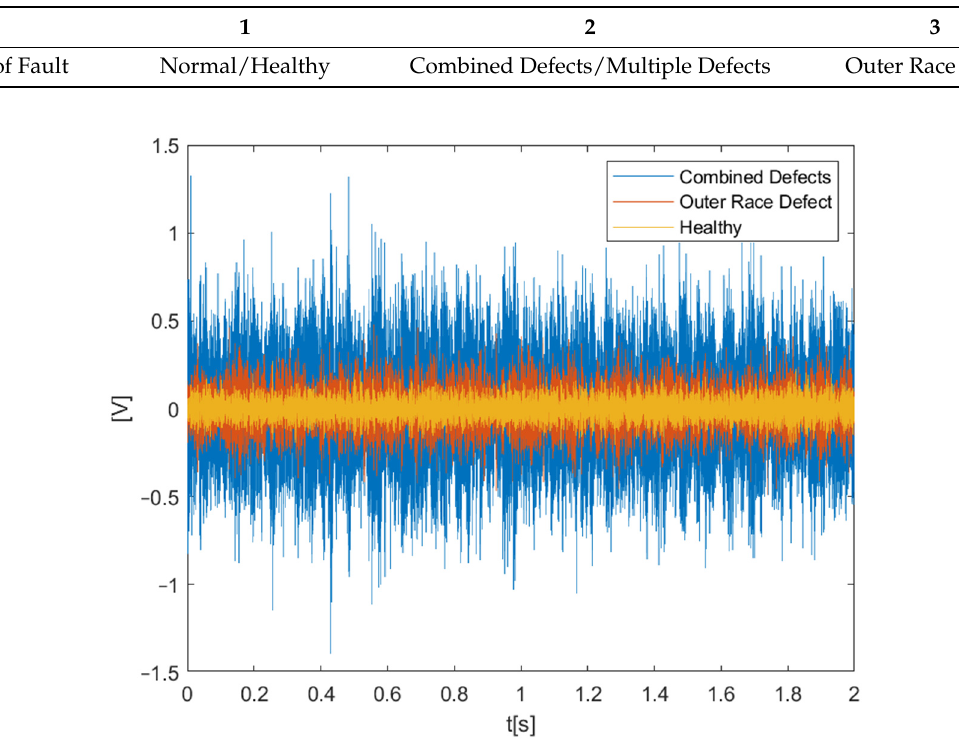
Figure 8. Raw vibration signal in the time domain.